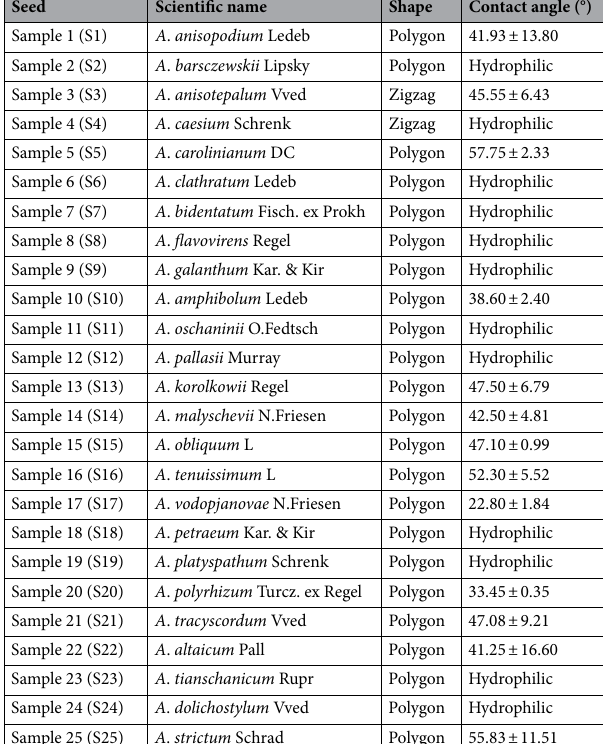
Table 1. Contact angles and shapes of Allium seeds.